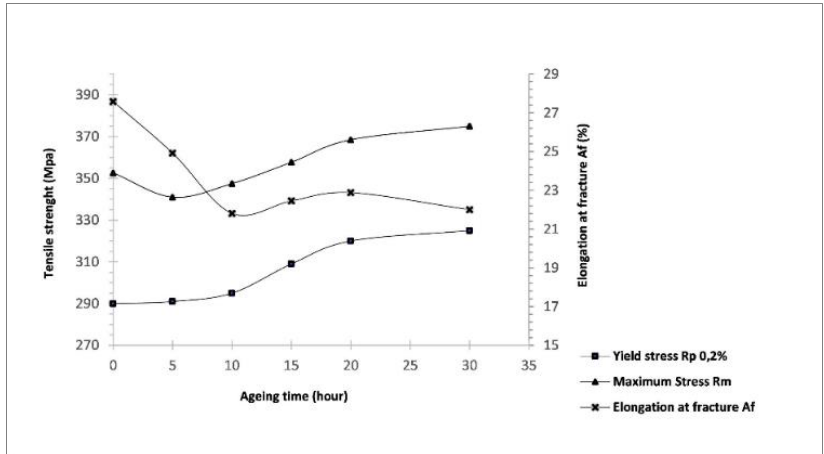
Fig. 7. Mechanical properties of the 2017A-T4 alloy at different aging conditions. From 10 to 30 h, an increase in maximum stress 𝑅 accompanied by a decrease of elongation at fracture 𝐴 𝑅 𝒑 𝟎.𝟐% the presence of Al 2 Cu hardening precipitates corresponding to aging at 170 °C for 15, 20 and 30 h of duration. These evolutions reflect a hardening of the structure and can be related to changes in